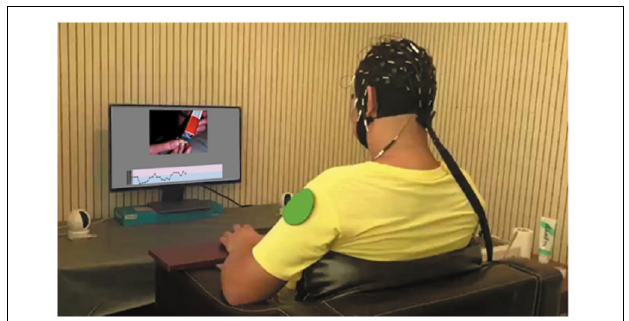
FIGURE 3 | One scene of a participant in the phase of neurofeedback regulation training. A participant is wearing EEG cap and watching neurofeedback display. A camera to monitor the status of the participant.